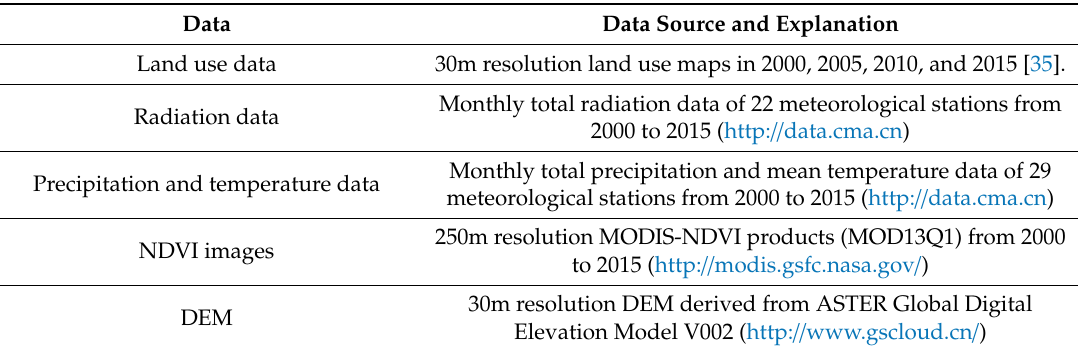
Table 1. The study data sources and their